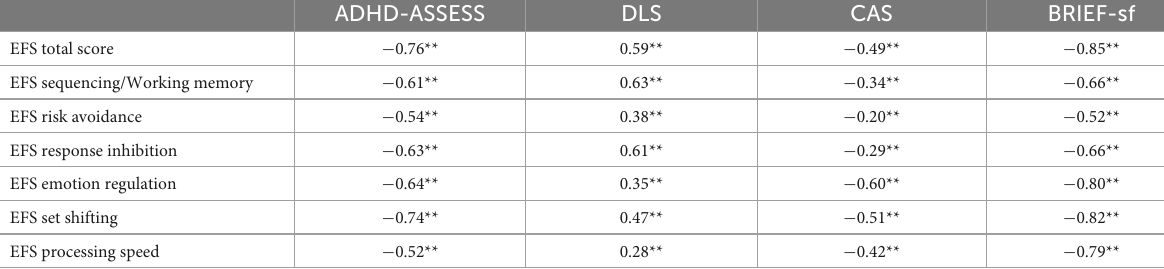
TABLE 4 Executive Functioning Scale (EFS) convergent and discriminant validity.